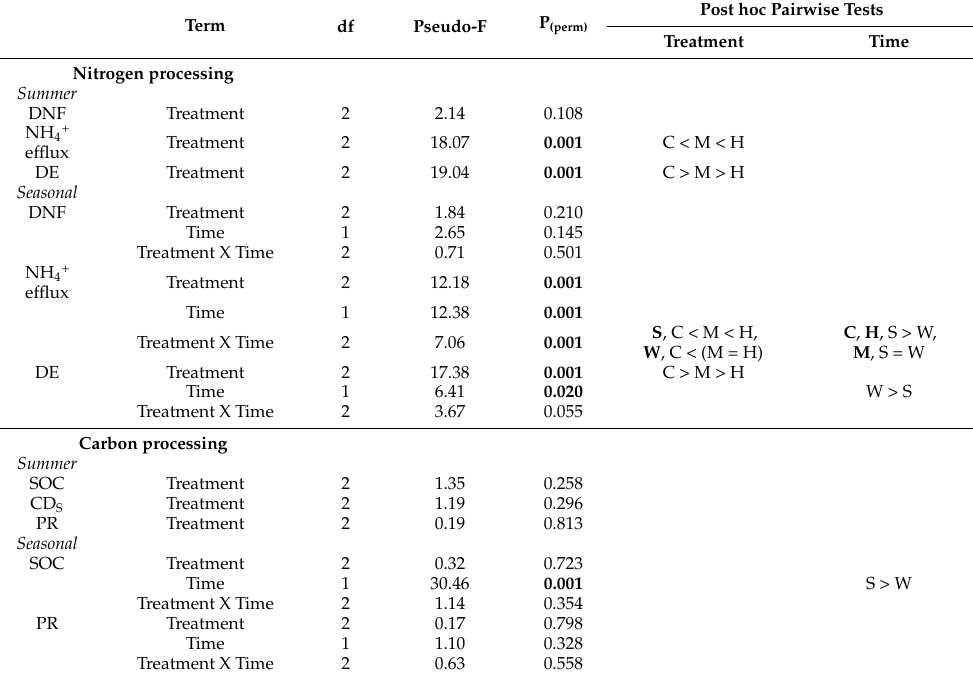
Table 2. Results of one-way PERMANOVAs comparing summer univariate measures of nitrogen and carbon processing as a function of nutrient enrichment treatment (n = 18). Repeated measures two-way PERMANOVAs are used to compare summer and winter values at three sites (n = 9). Significant effects ( p < 0.05) are given in bold and post hoc pairwise tests are shown for significant interactions. Nutrient enrichment treatments have been abbreviated to C = control, M = medium, H = high, and winter and summer to W and S,